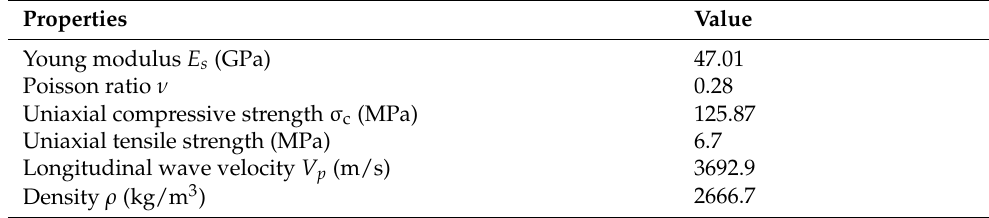
Table 1. Basic physical and mechanical parameters of the granite sample.